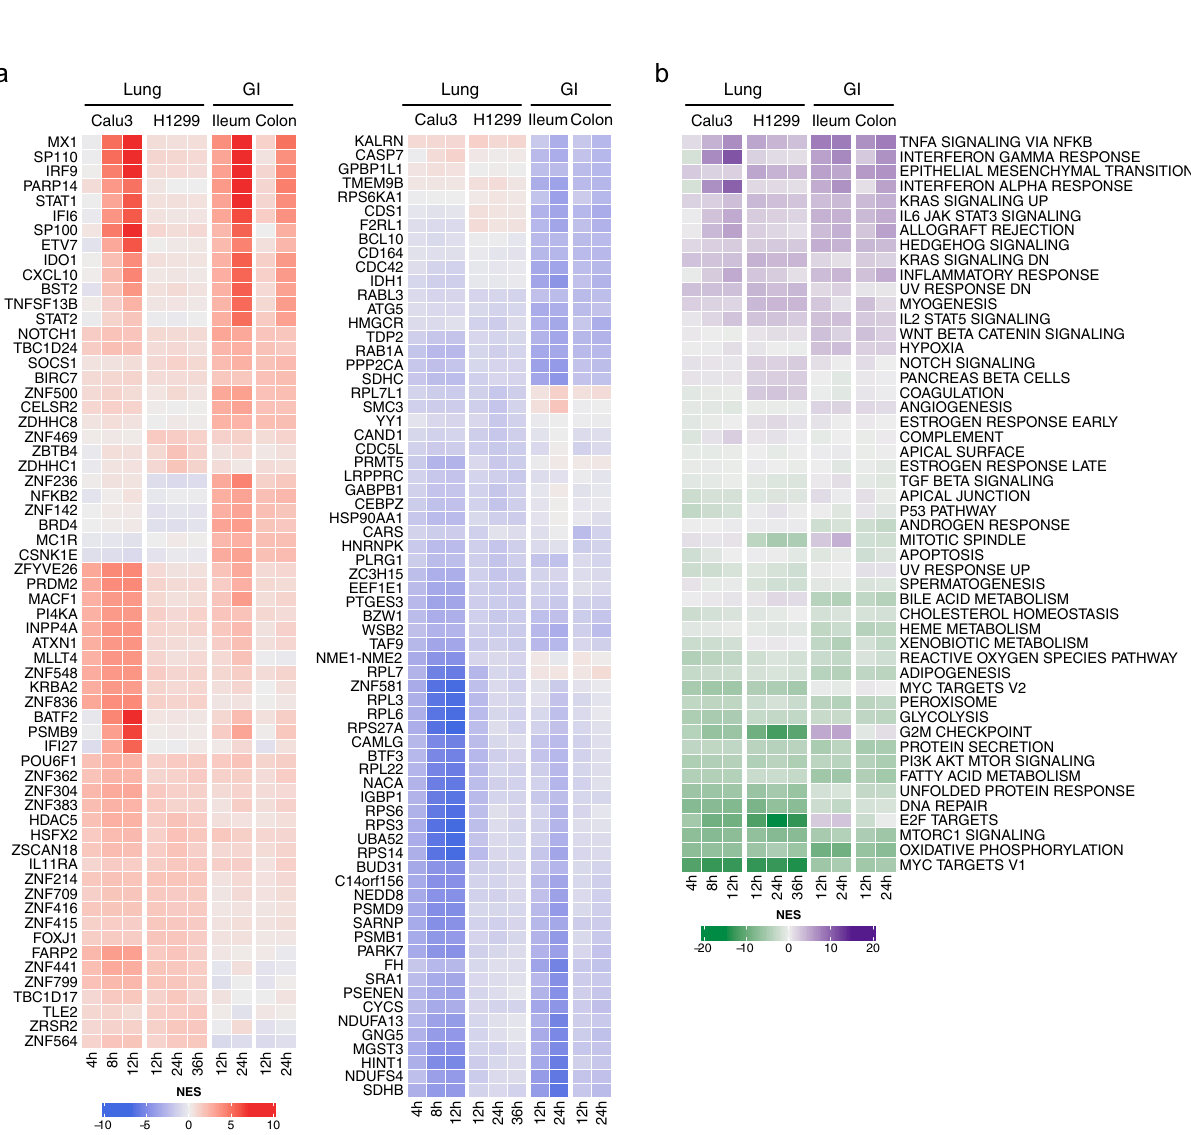
Fig. 1 Changes in host cell protein activity in response to SARS-CoV-2 virus infection. a Left, heatmap showing the VIPER-inferred differential activity of the top 10 most activated proteins in response to SARS-CoV-2 infection in each of the models and time-points pro fi led (62 proteins across all evaluated conditions) at the single-cell level. Right, heatmap showing the activity of the top 10 most inactivated proteins in response to SARS-CoV-2 infection in each of the models and time-points pro fi led (69 proteins across all evaluated conditions) at the single-cell level. Differential protein activity is expressed in Normalized Enrichment Score (NES) units with protein inactivation and activation induced by SARS-CoV-2 infection shown in blue and red color, respectively. b Heatmap showing the enrichment of biological hallmarks in the SARS-CoV-2-induced protein activity signatures. Shown is the NES estimated by the aREA algorithm, with purple color indicating enrichment in the over activated proteins and green color indicating enrichment in the inactivated